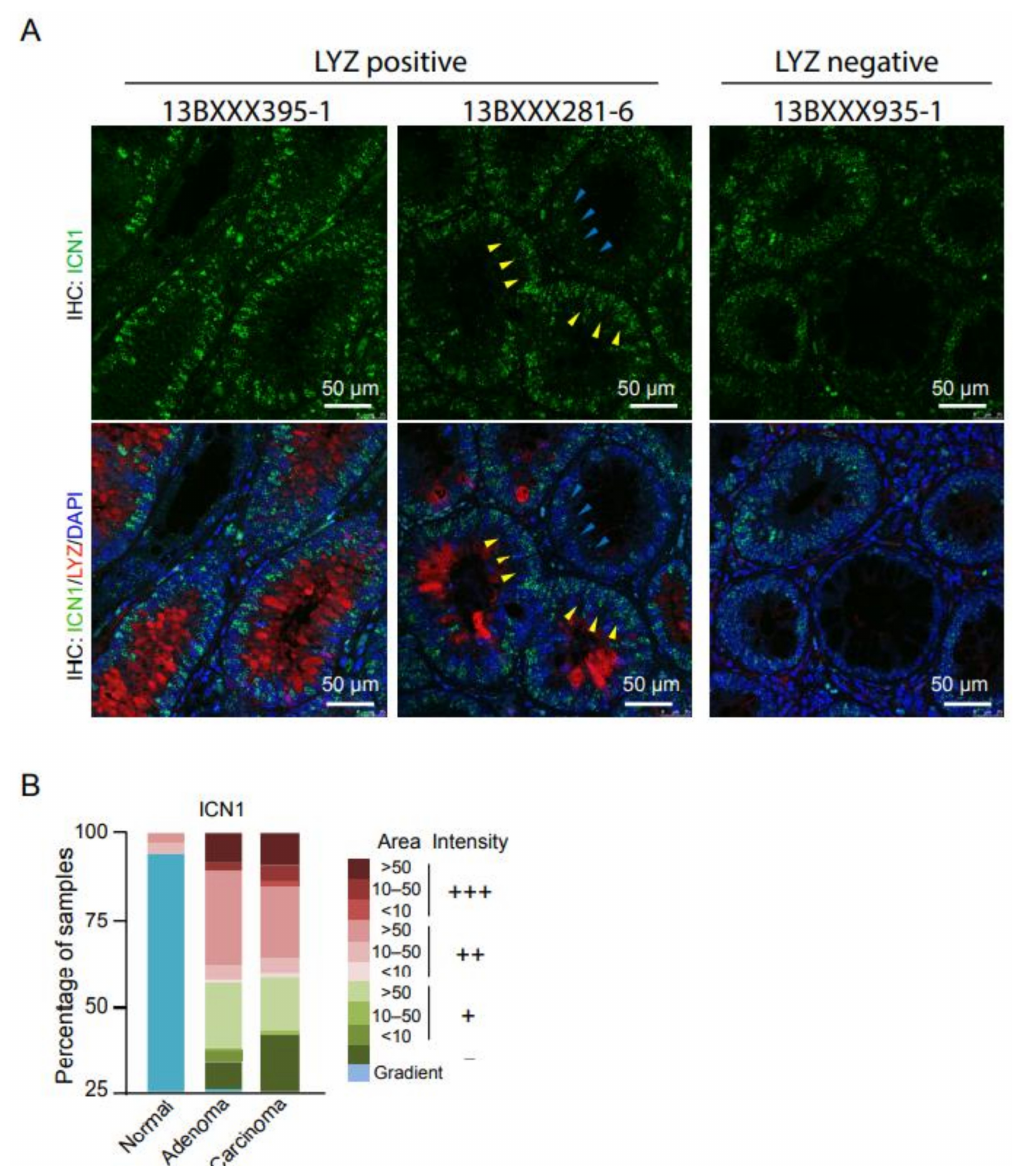
Figure 3. Notch1 activity is higher in adenoma cells of the Paneth-enriched areas. ( A ) Double immunofluorescence (IF) analysis of active Notch1 (ICN1) and LYZ in the indicated samples. DAPI was use for nuclei detection. ( B ) Quantification of the intensity of staining and area of the tissue (normal of tumoral) that was considered positive for active Notch1. Color code indicates the intensity and the area covered by ICN1-positive